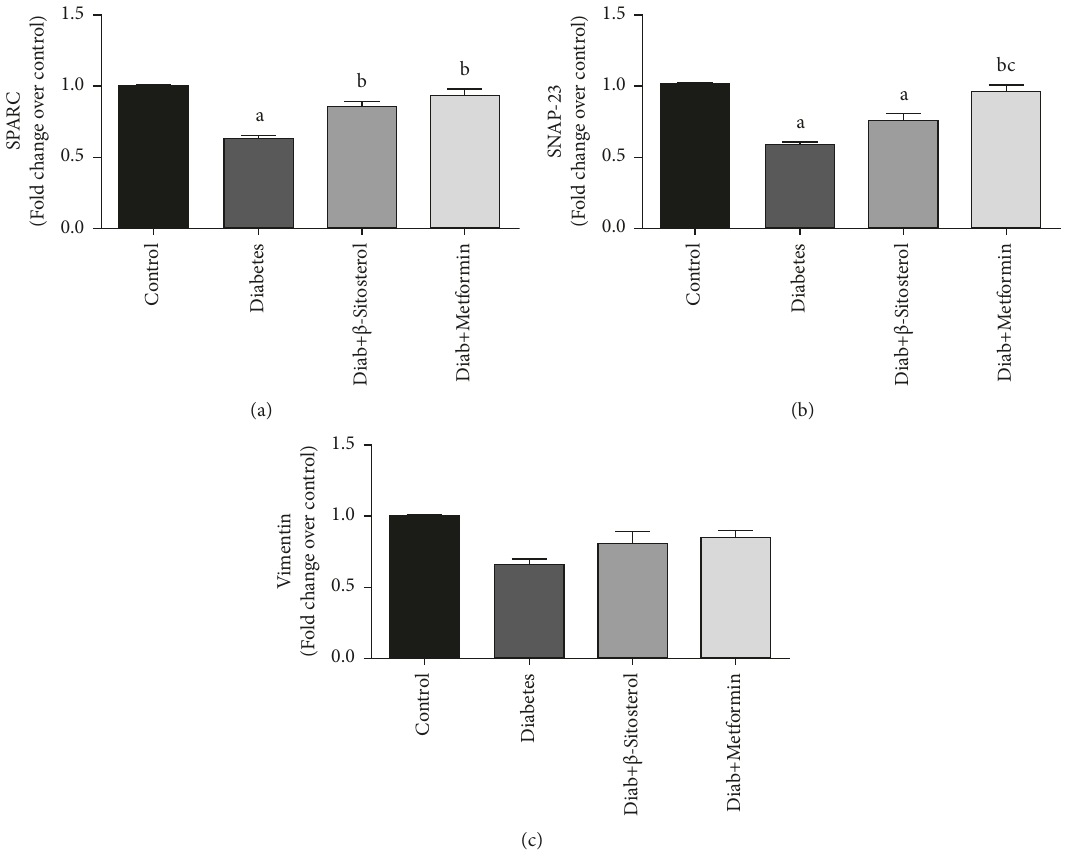
Figure 7: (a–c): The effect of β -sitosterol on the expression levels of SPARC, SNAP23, and vimentin in diet-fed diabetic rats was studied by real-time PCR. Mean ± SEM of 6 animals was represented in each bar. The values, which were significant ( p < 0 . 05), were compared with a—control, b—diabetic control, and c— β -sitosterol-treated diabetic group. Vimentin showed no significant change in its mRNA expression between the groups (c). (a) SPARC mRNA. (b) SNAP23 mRNA. (c) Vimentin